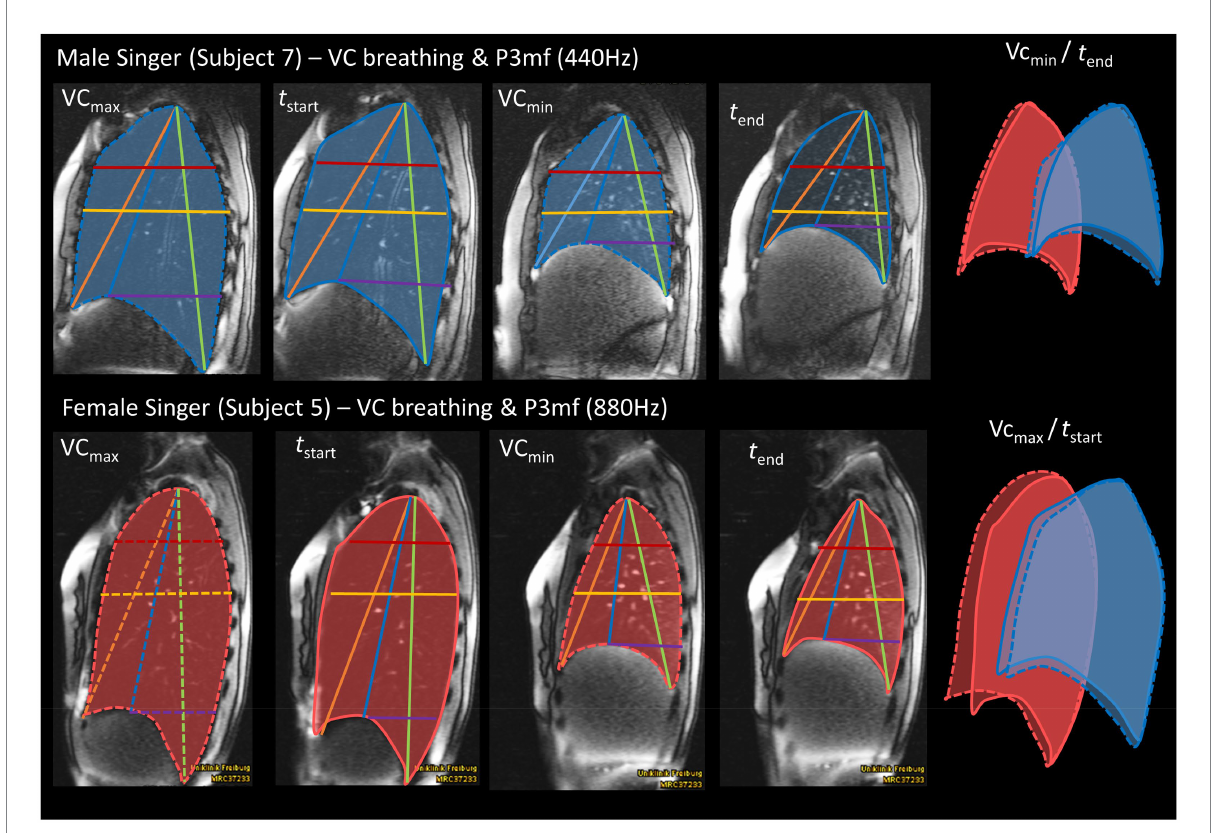
FIGURE 5 Exemplary illustration of a female singers’ reduction and male singers accentuation of thorax elevation for phonation compared to vital capacity breathing. The figure displays MR images of an example male (10) and female (5) subject during maximum inhalation ( VC max ), maximum exhalation ( VC min ), start of sustained phonation ( t start ) and end of sustained phonation ( t end ). A corresponding pitch (P3 mf, 880 Hz in female/440 Hz in male) was chosen. The superimposed lung cross-sections of a sagittal MR image illustrate that the female singer reduced her thoracic inhalation movement for phonation, while it was increased by the male singer.